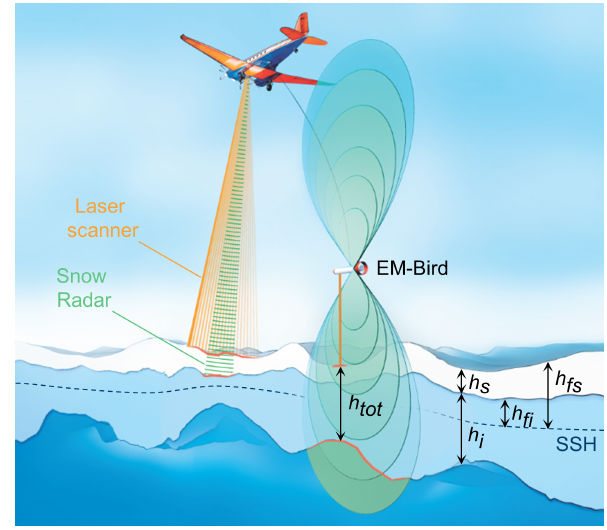
Figure 1. Sketch of the IceBird sea-ice campaign setup with the EM-Bird (black text), the laser scanner (orange), and the Snow Radar (green). Different components of sea ice are highlighted in the cross section: total (ice + snow) thickness ( h tot ), snow depth ( h s ), sea-ice thickness ( h i ), sea-ice freeboard ( h fi ), and snow free- board ( h fs ). SSH stands for local sea-surface height, depicted by the blue dashed line. Adapted with annotations from the graphic by Alfred Wegener Institute/Martin Künsting CC-BY 4.0.